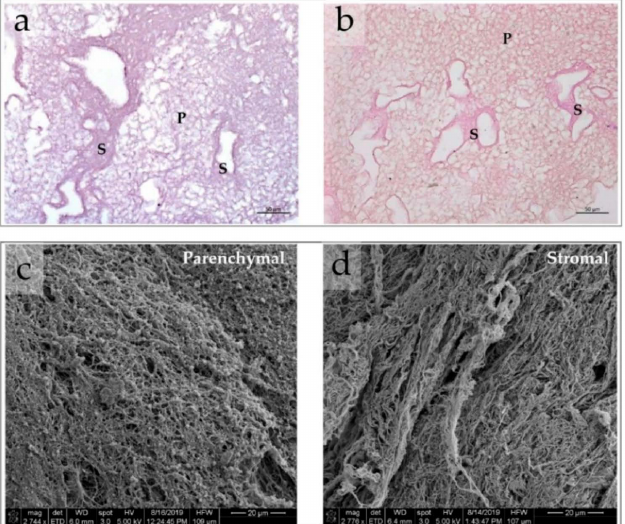
Figure 4. ( a , b ) Histological features of CE liver AOSSs. Complete removal of the cells and compart- mental structure of the liver ECMs is clearly visible in samples stained by the hematoxylin and eosin ( a ) and Van Gieson’s (VG) ( b ) methods. The elements of the parenchymal (labeled “P”) and stromal (labeled “S”) compartments of the CE liver ECMs. The ECM of the parenchymal compartment is loose and mesh-like, with randomly oriented matrix elements of the former Disse’s space; while the ECM of the stromal compartment is denser, with more aligned and more fuchsinofilic (pink-red when stained by the VG method). The VG staining reveals the collagenous nature of the liver AOSSs and indicates the higher contents of fibrous/crosslinked collagen in the stromal compartment in comparison to the parenchymal one. Scale bars, 50 µ m. ( c , d ) SEM images of CE liver AOSSs. Scale bars, 20 µ m. The fragments representing parenchymal ( c ) and stromal ( d ) compartments are shown. Parenchymal compartment is characterized by a fine, random, mesh-like structure, while the stromal LS-ECM is composed of coarser and more parallel aligned fibrillar